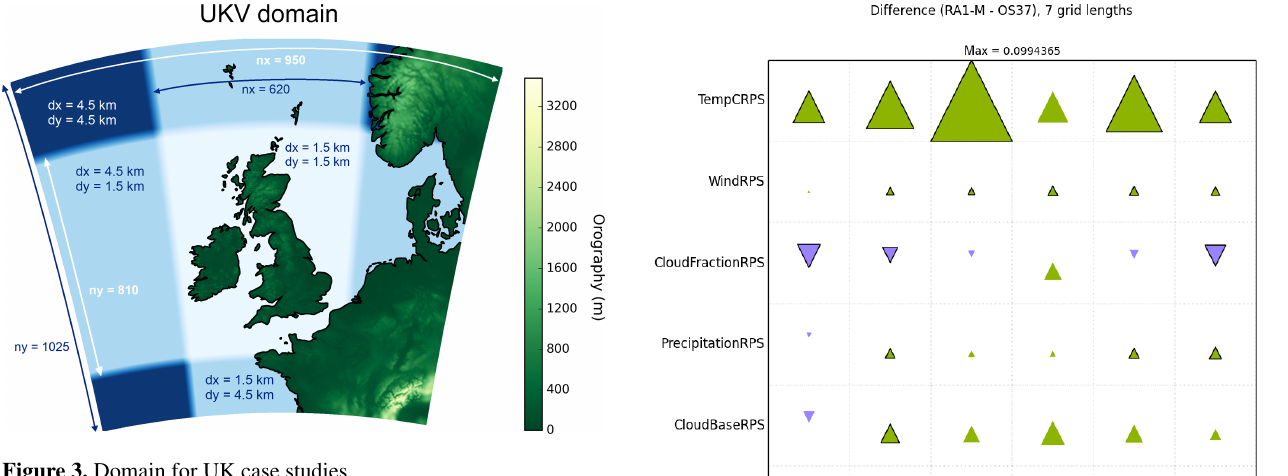
Figure 3. Domain for UK case studies.